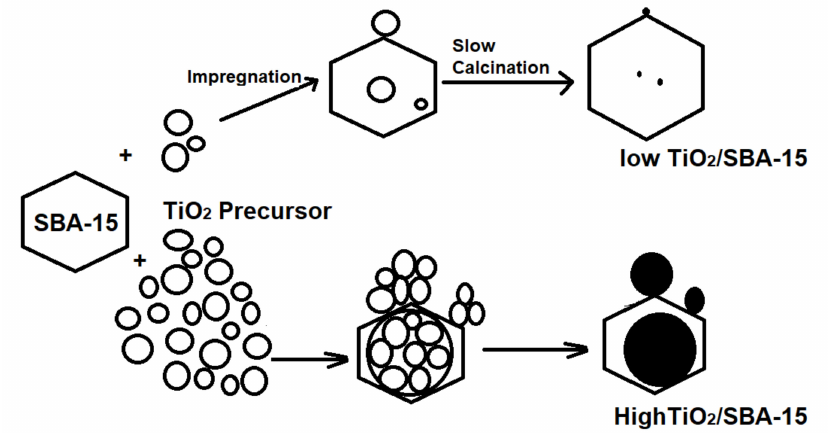
Figure 7. The illustration showed the benefits of the slow calcination process in depositing titania onto SBA-15.